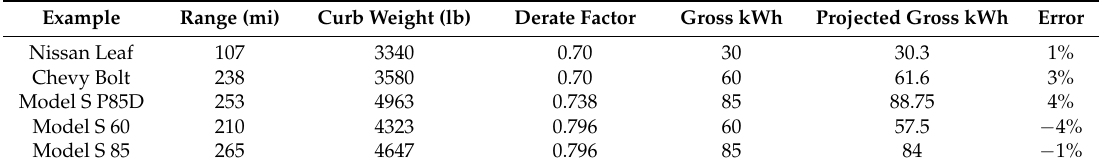
Table 3. Comparison of projected capacities to those of selected production